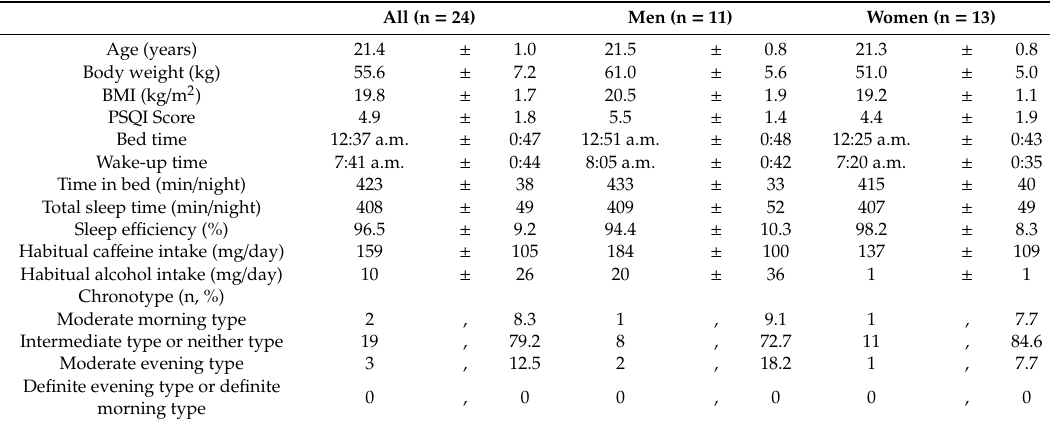
Table 1. Characteristics of the participants before the